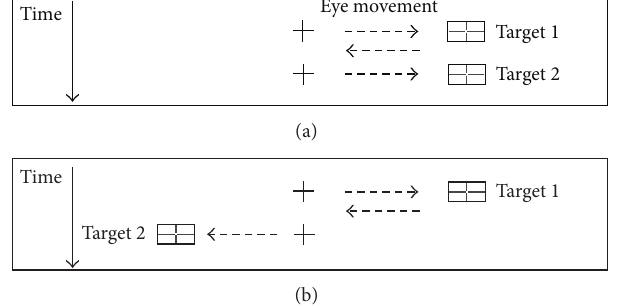
Figure 2: Operationalisation of target prior location for inhibition of saccadic return. Centre cross is fixation. Dashed arrows represent eye movements, with time down the page. (a) is ipsilateral prior location and (b) is contralateral prior